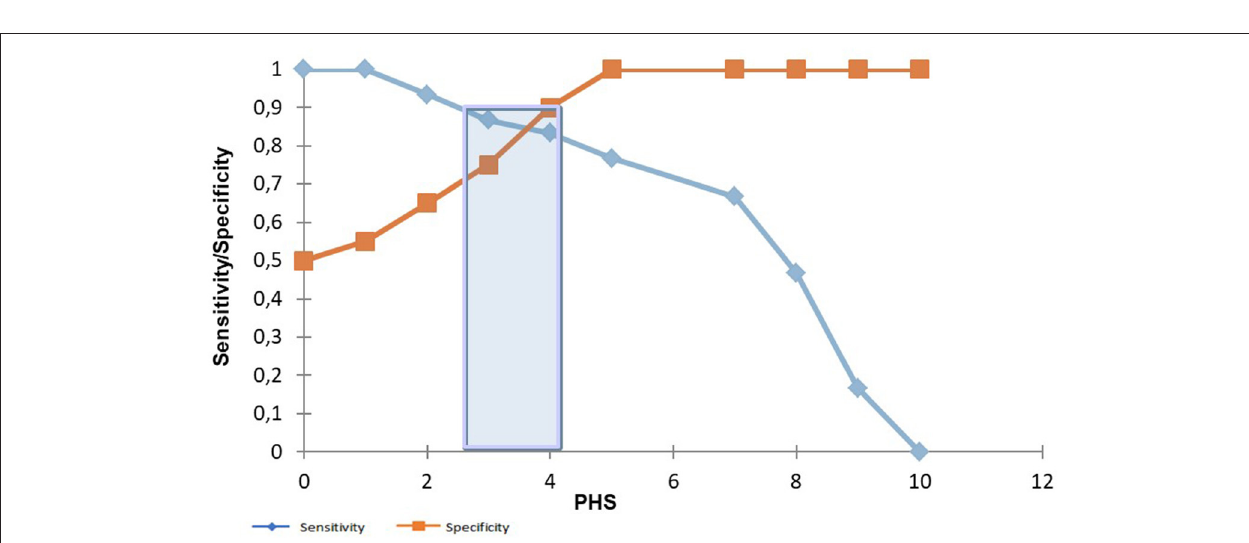
FIGURE 4 | Comparison between sensitivity and specificity with the pulmonary hypertension score (PHS). A gray zone approach, presented by the blue bar. When a score of 5/10 is reached, a sensitivity of 77% and a specificity of 100% are reached to detect moderate to severe PCPH. When a score of 2/10 is obtained, a sensitivity of 93% and a specificity of 65% are reached to detect moderate to severe